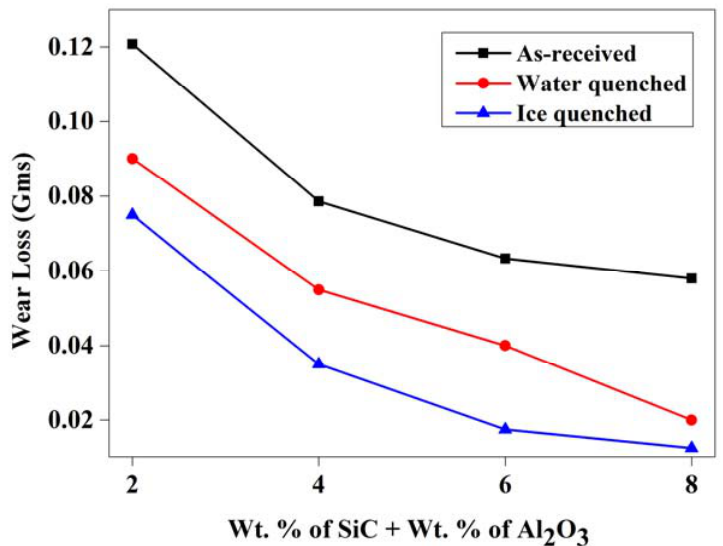
Figure 7: Wear loss with varying content of SiC and Al 2 O 3